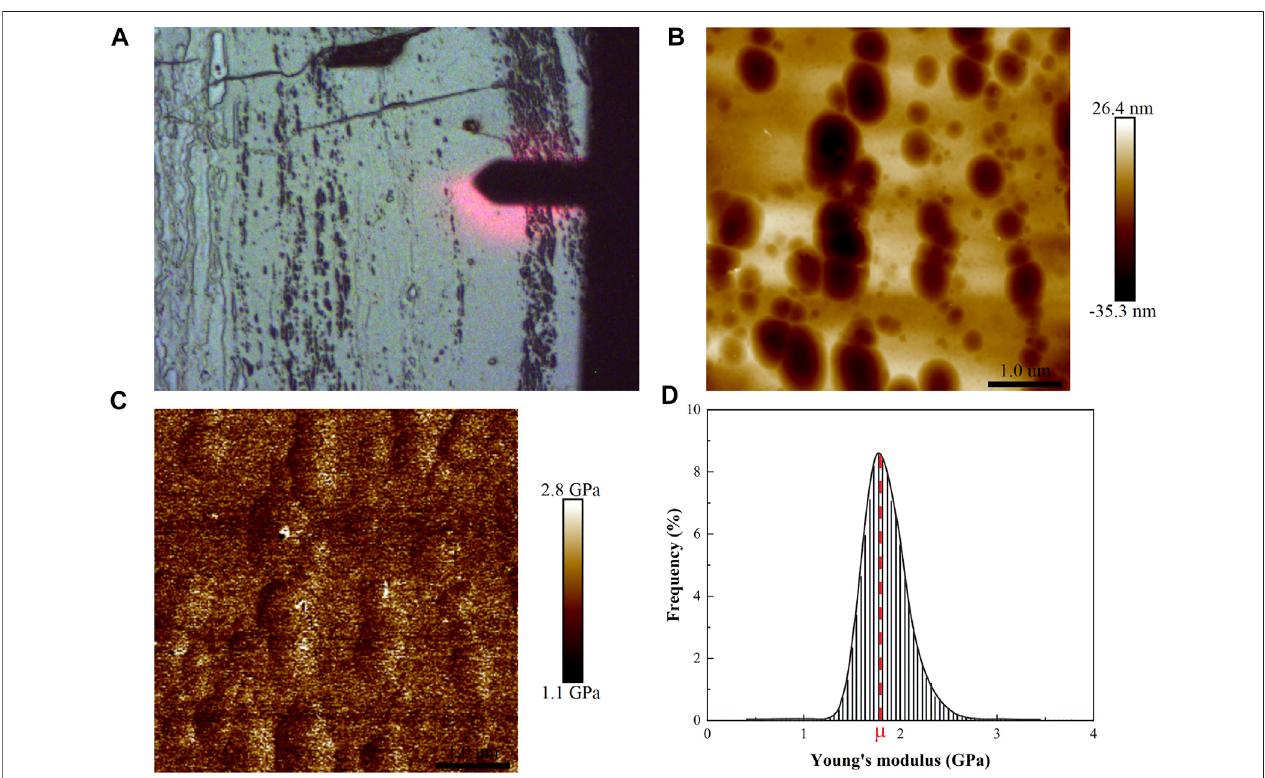
FIGURE 4 | Microscope and AFM images in the same region of sample WG-6. (A) Scanning probe on the vitrinite; (B) AFM topography image; (C) AFM Young ’ s modulus image; (D) Histogram of Young ’ s modulus from the “ Roughness ” module.